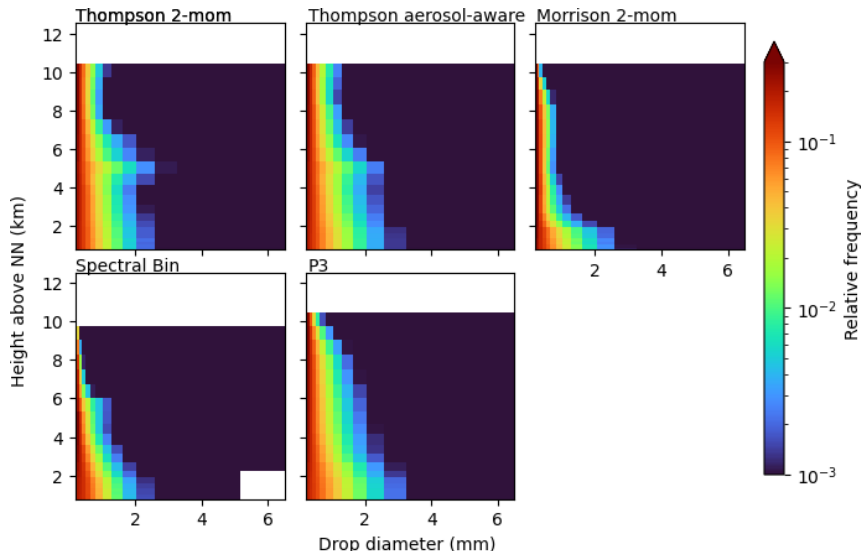
Figure B5. CFADs of simulated raindrop size distributions during the measurement periods over 5 convective days in 2019.